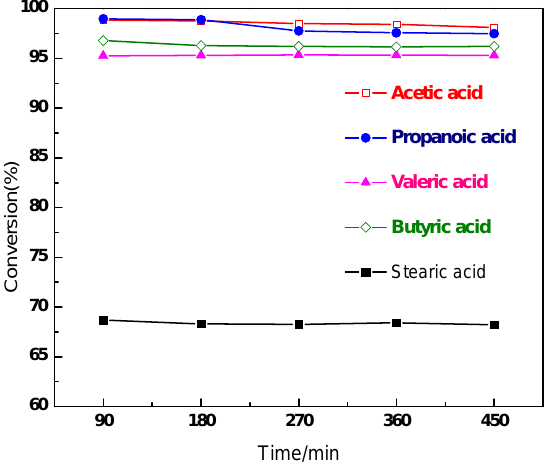
Figure 6. Effect of chain length of model compounds with the same functional group on conversion. Reaction conditions: T = 270 °C, WHSV =2 h − 1 , H 2 /feedstock = 400, P = 4.0